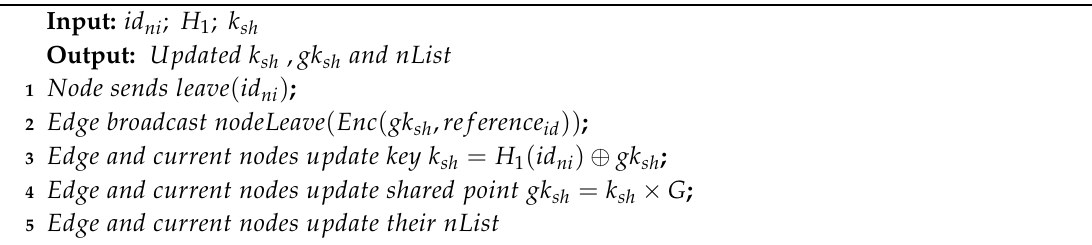
Algorithm 3: Updating k sh , gk sh , and nList for node leaving the group.